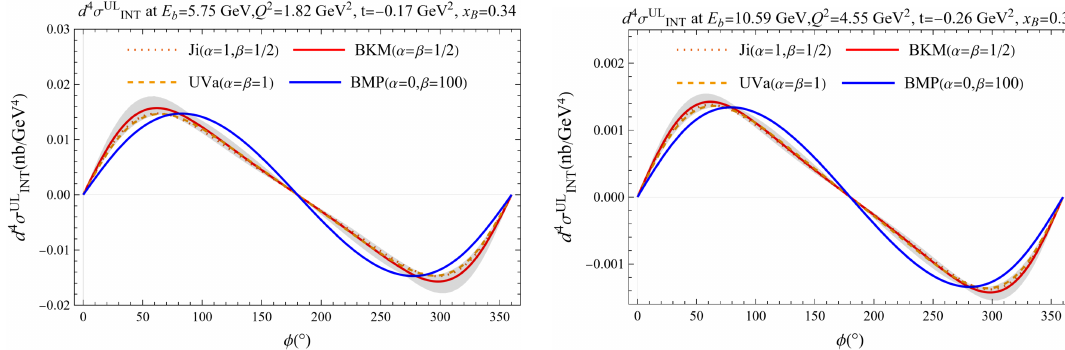
of different choice of α INT